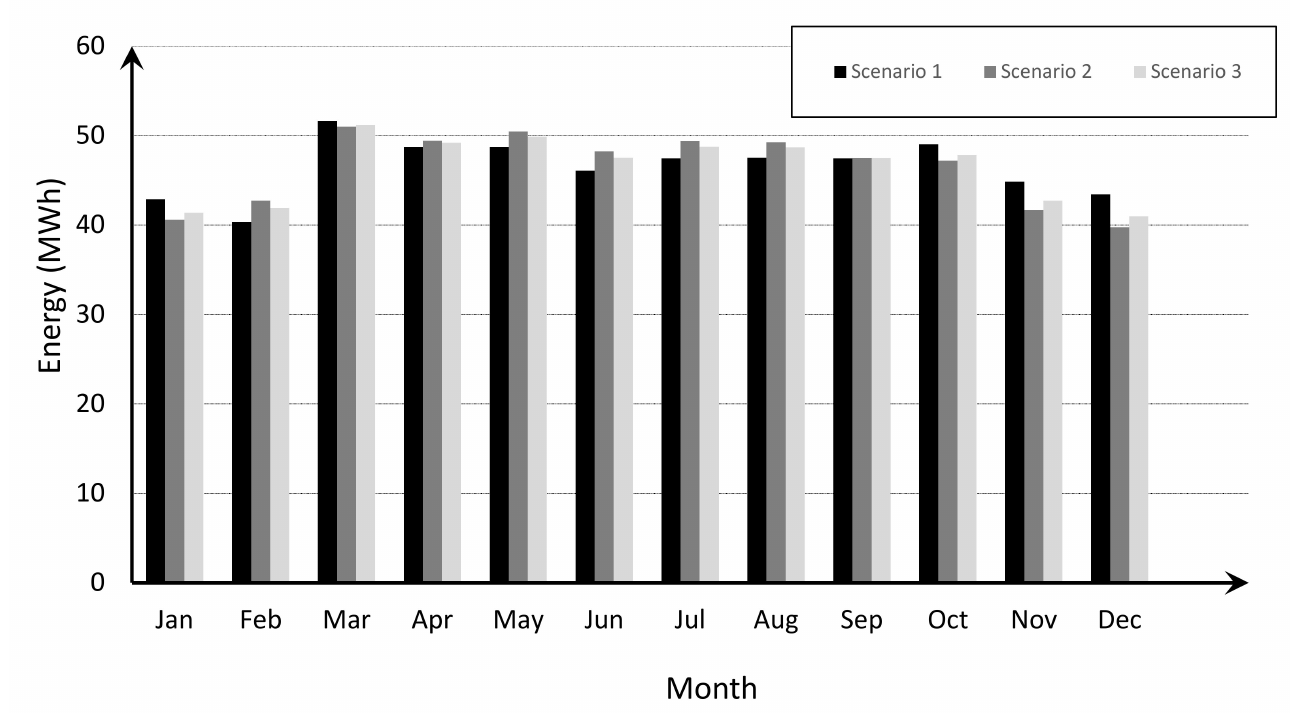
Figure 8. Energy production for all scenarios on a monthly basis.